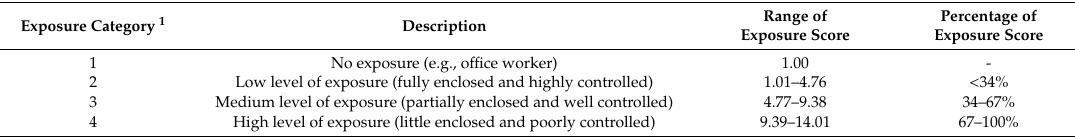
Table 2. The classified exposure category and associated descriptions depending on the range of exposure scores and percentages.